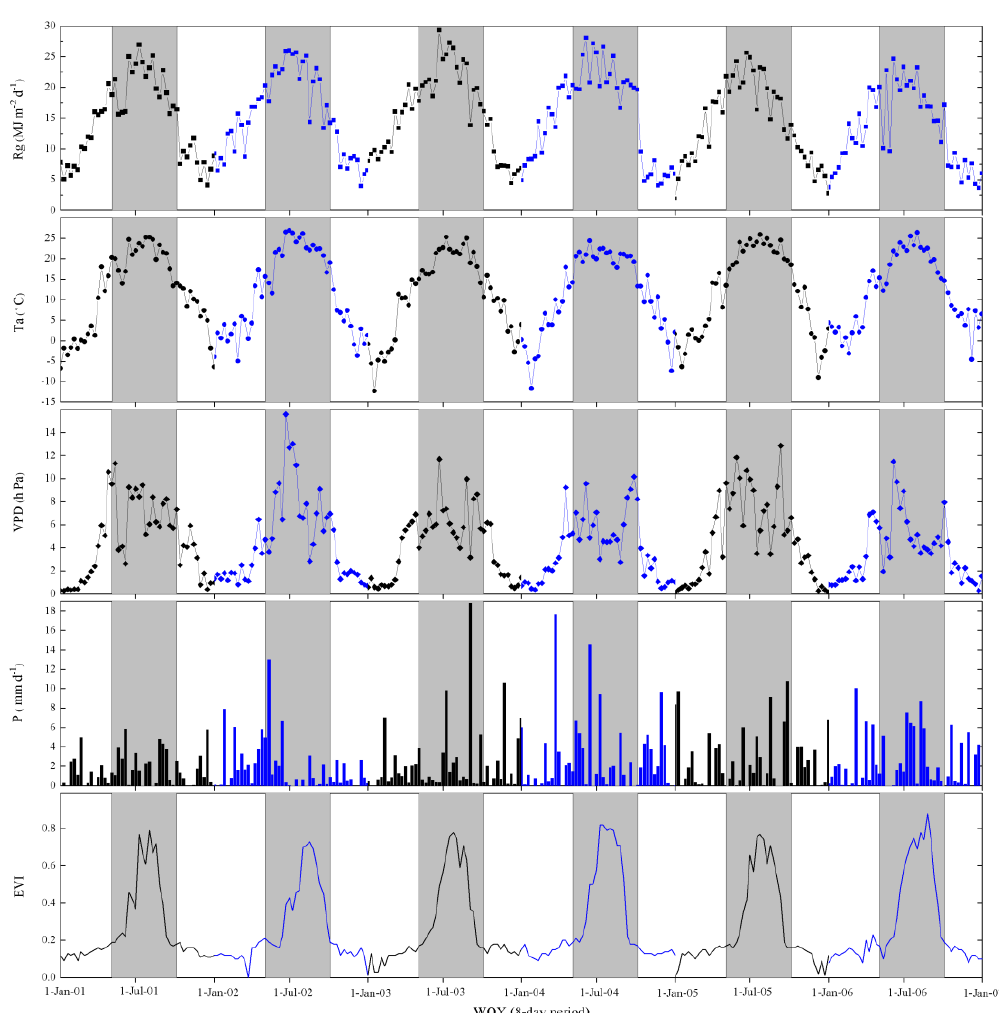
Figure 2. Seasonal and interannual variations of solar radiation (R g ), air temperature (T a ), vapor pressure deficit (VPD), precipitation (P) and enhanced vegetation index (EVI) observed at the annual corn/soybean rotation field (US-Bo1) during 2001–2006, with the growing season